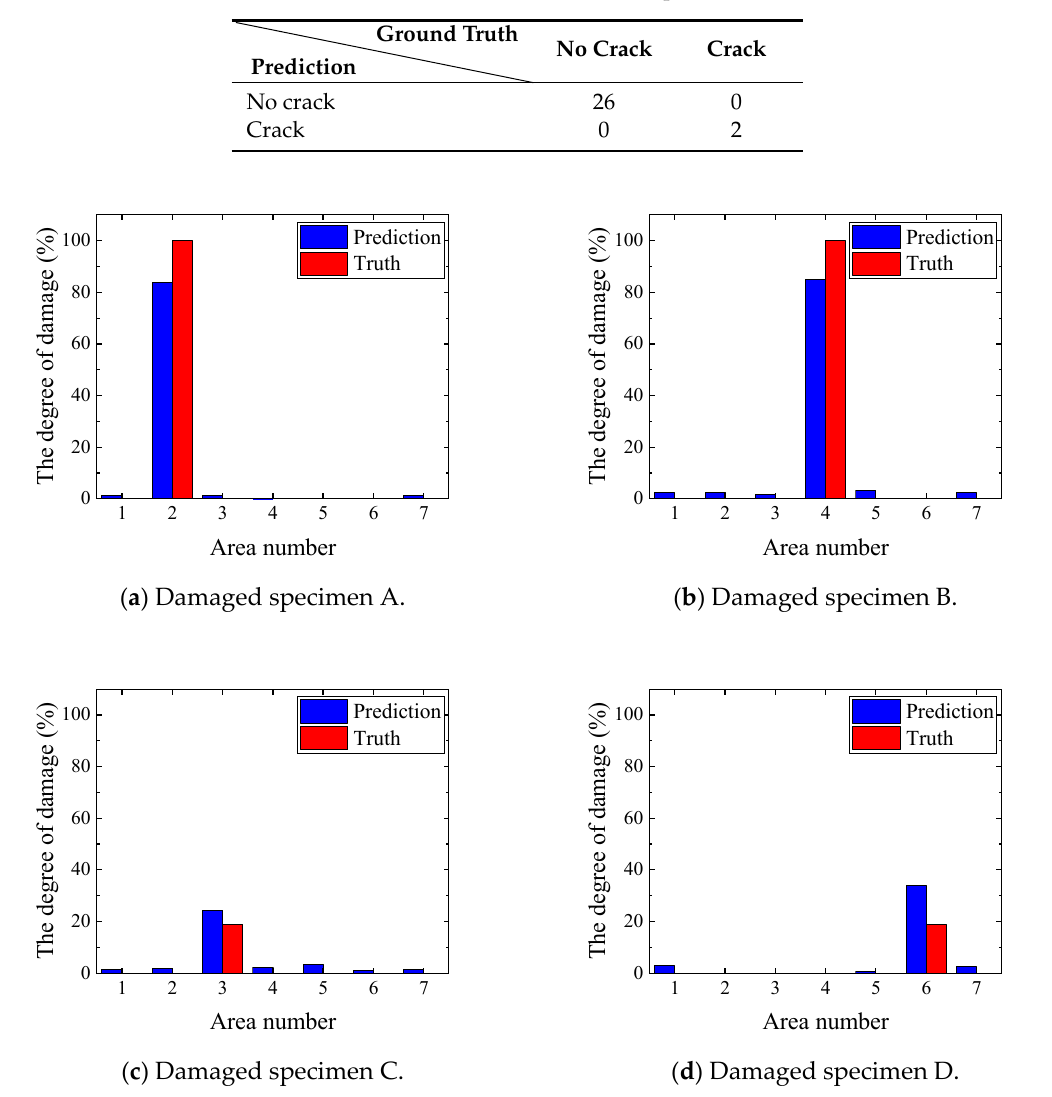
Figure 17. Analysis results of actual damaged specimens.